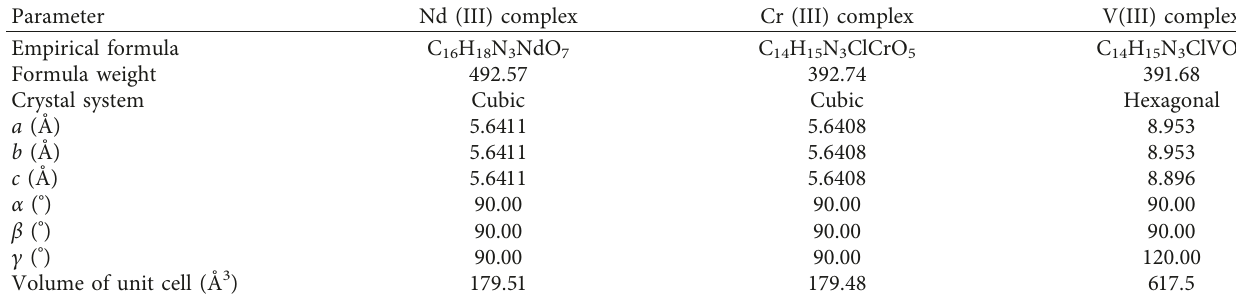
Figure 15: XRD pattern of V 2 O 3 NPs. Table 6: X-ray diffraction crystal data for compounds.